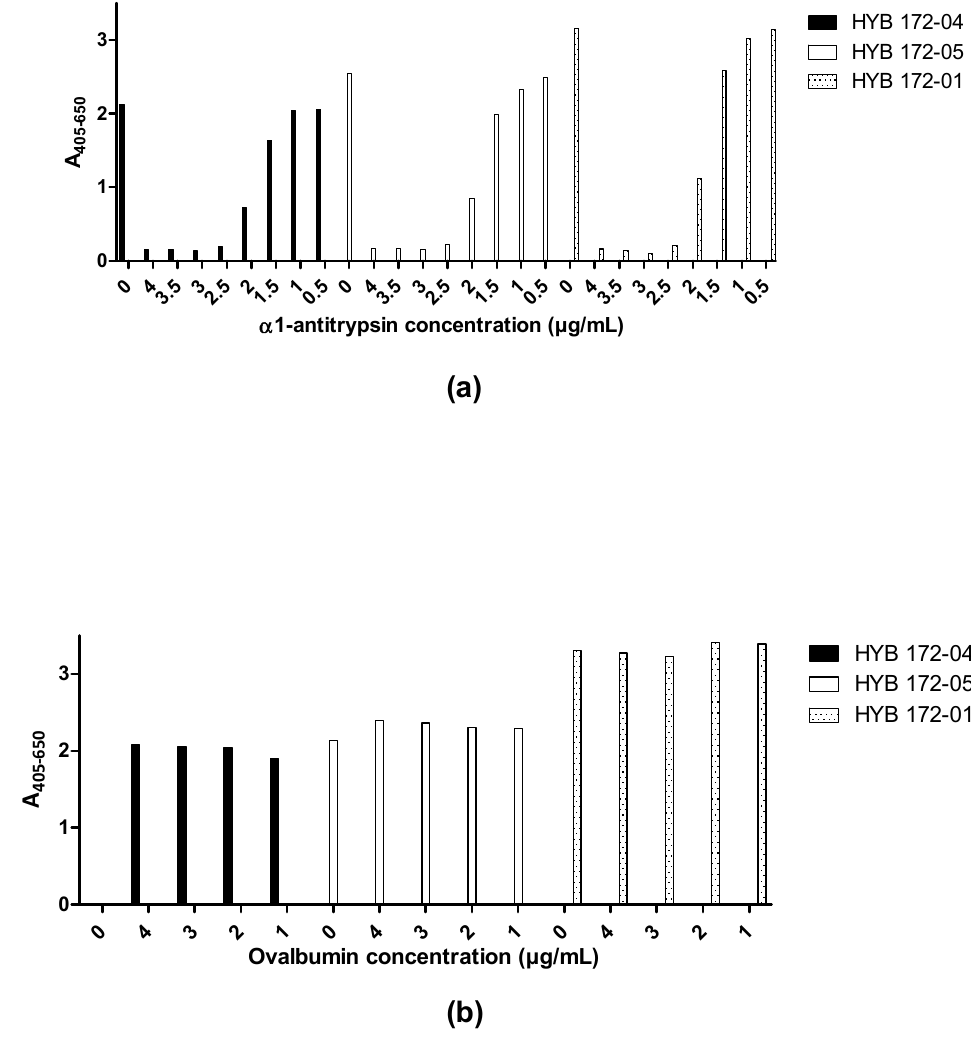
Figure 7. Inhibition by α 1-antitrypsin of MAb interaction with PR3 (SSI) analysed by ELISA. ( a ) Inhibition of HYB 172-04, 172-05 and 172-01 with α 1-antitrypsin. α 1-antitrypsin was pre-incubated in increasing concentrations with PR3 (0.1 µ g/well) before coating. ( b ) Control with incubation of HYB 172-04, 172-05 and 172-01 with ovalbumin. Ovalbumin was pre-incubated in increasing concentrations with PR3 (0.1 µg/well) before coating.